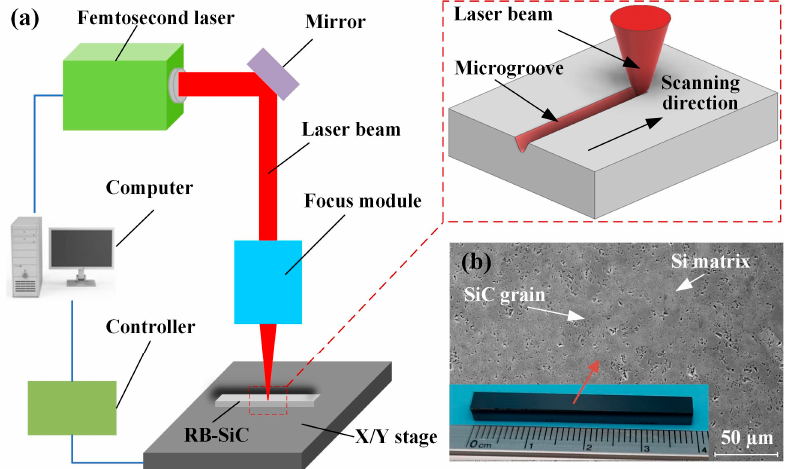
Figure 1. Schematic diagram of femtosecond laser system and materials: ( a ) schematic illustration of the laser system and ( b ) SEM image of RB-SiC. Table 1. The processing parameters applied for femtosecond laser scanning.